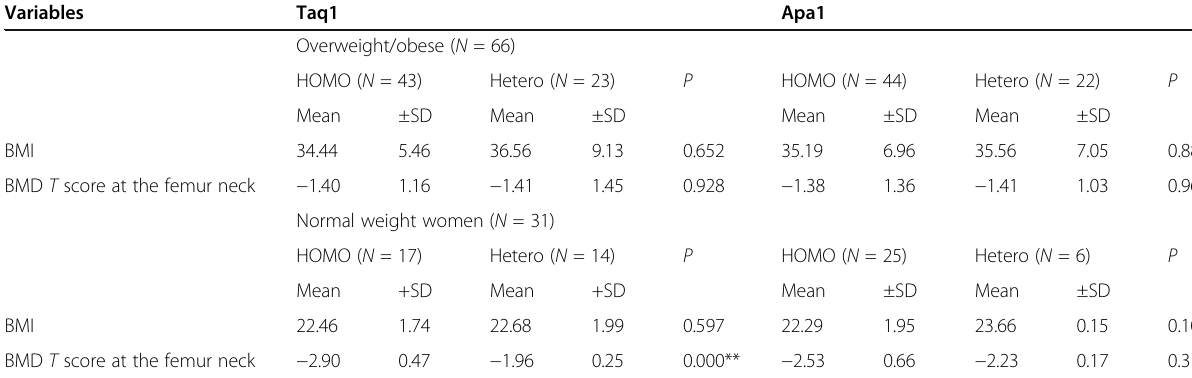
Table 3 Comparisons of means ± SD of BMI and BMD between different genotypes of TaqI and ApaI VDR among overweight/ obese and normal weight women